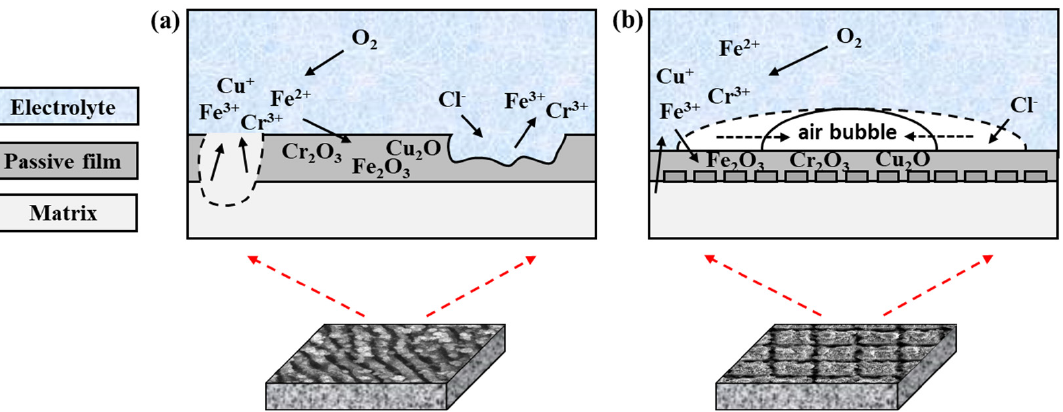
Figure 10. Schematic illustrating the corrosion mechanism of ( a ) hydrophilic and ( b ) SH 17-4PH SS.